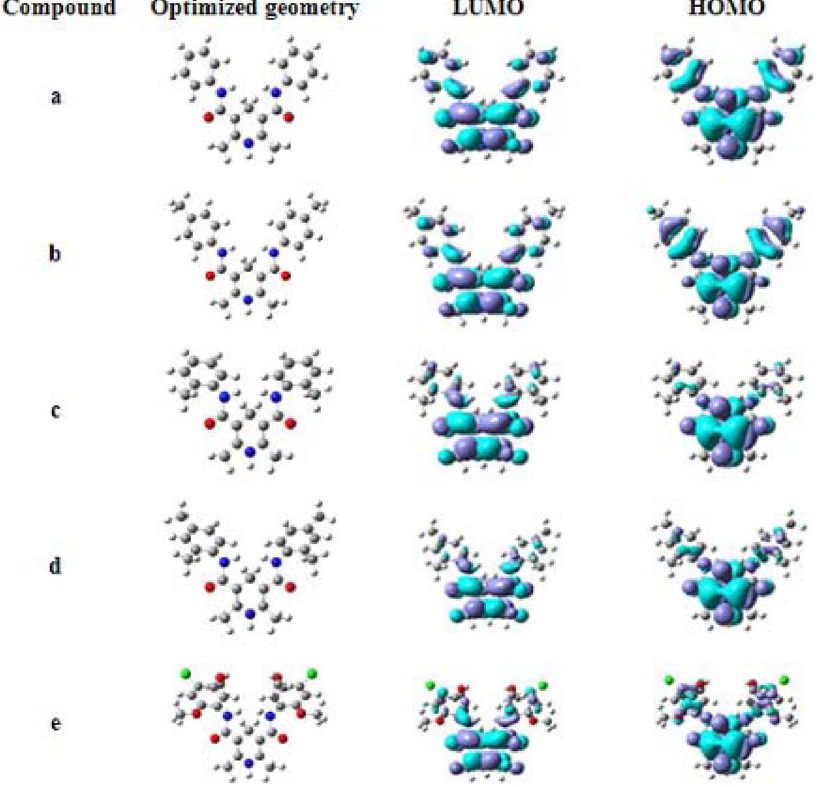
Figure 4. The optimized geometries and the surfaces of the frontier molecular orbital of a-e obtained at the B3LYP/6-31G (d) level.